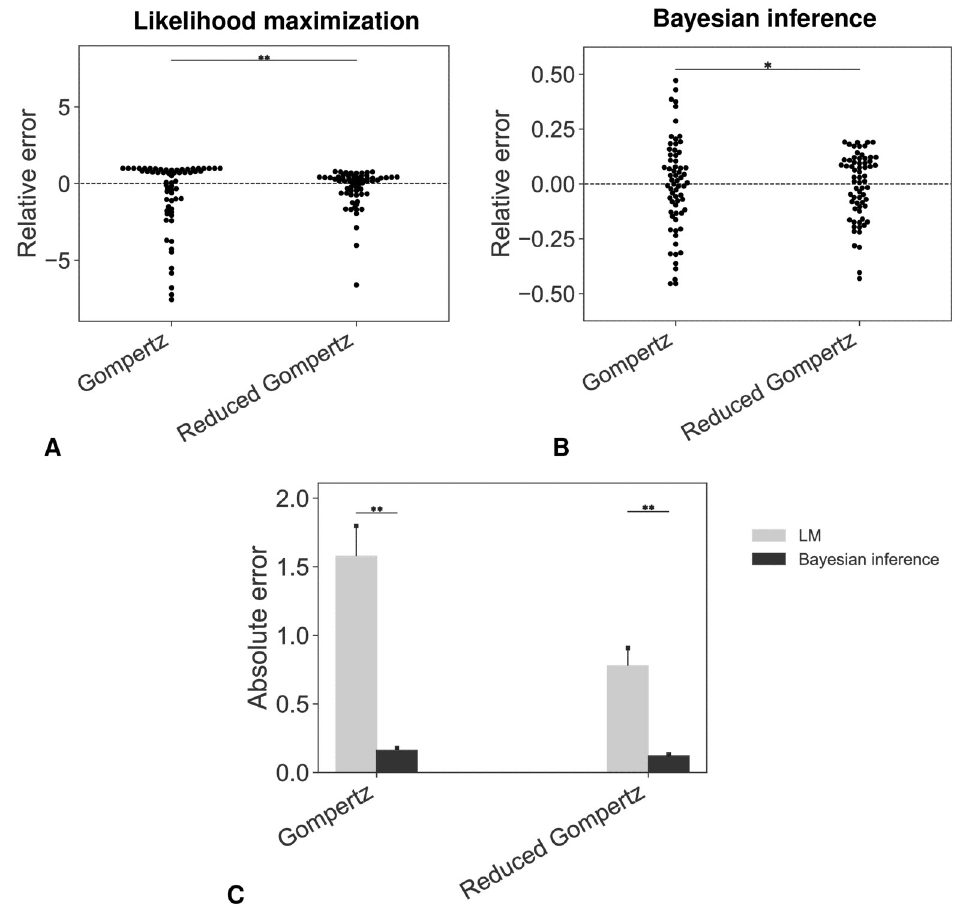
Fig 5. Accuracy of the prediction models. Swarmplots of relative errors obtained under likelihood maximization (A) or Bayesian inference (B) ( � p -value < 0.05, �� p -value < 0.01, Levene’s test). (C) Absolute errors: comparison between the different distributions ( � p -value < 0.05, �� p -value < 0.01, Wilcoxon test). In (A) three extreme outliers were omitted (values of the relative error were greater than 20) for both the Gompertz and the reduced Gompertz in order to ensure readability. LM = Likelihood